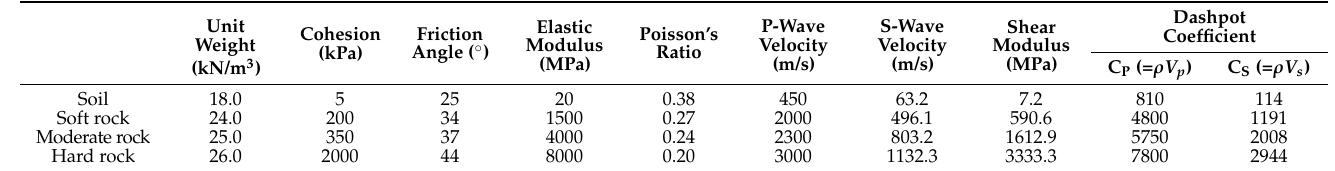
Table 5. Finite element method (FEM) model parameters for the ground.